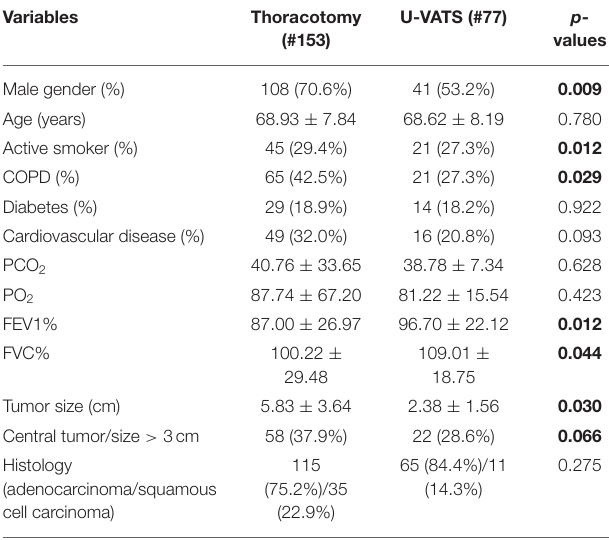
TABLE 1 | Clinical characteristics of the whole population.